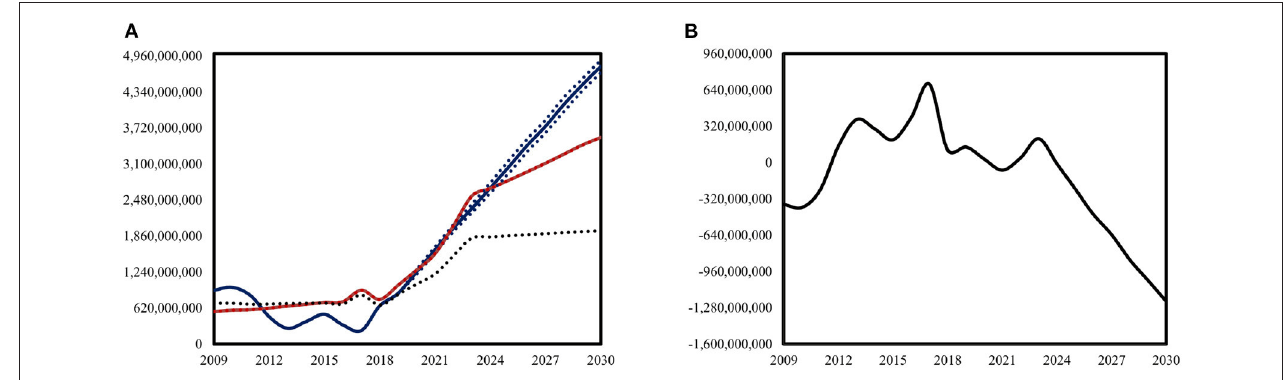
FIGURE 3 | (A) Optional costs dynamics. (B) Optional costs difference. ETS CO 2 -equivalent (tCO 2 e) cost. The x -axis represents the time-line. The y -axis measures the optional cost values of carbon allowances. In (A) , the blue line corresponds to the levels of cost calls (optional cost values). The blue dotted lines indicate the standard deviation of the cost calls. The red line corresponds to the levels of cost puts (optional benefit values). The black dotted line corresponds to the down-barrier optional cost values according to the public recommendations both on carbon prices and on the CO 2 -equivalent emissions’ reductions. In (B) , the black full line illustrates the difference between optional costs and benefits.